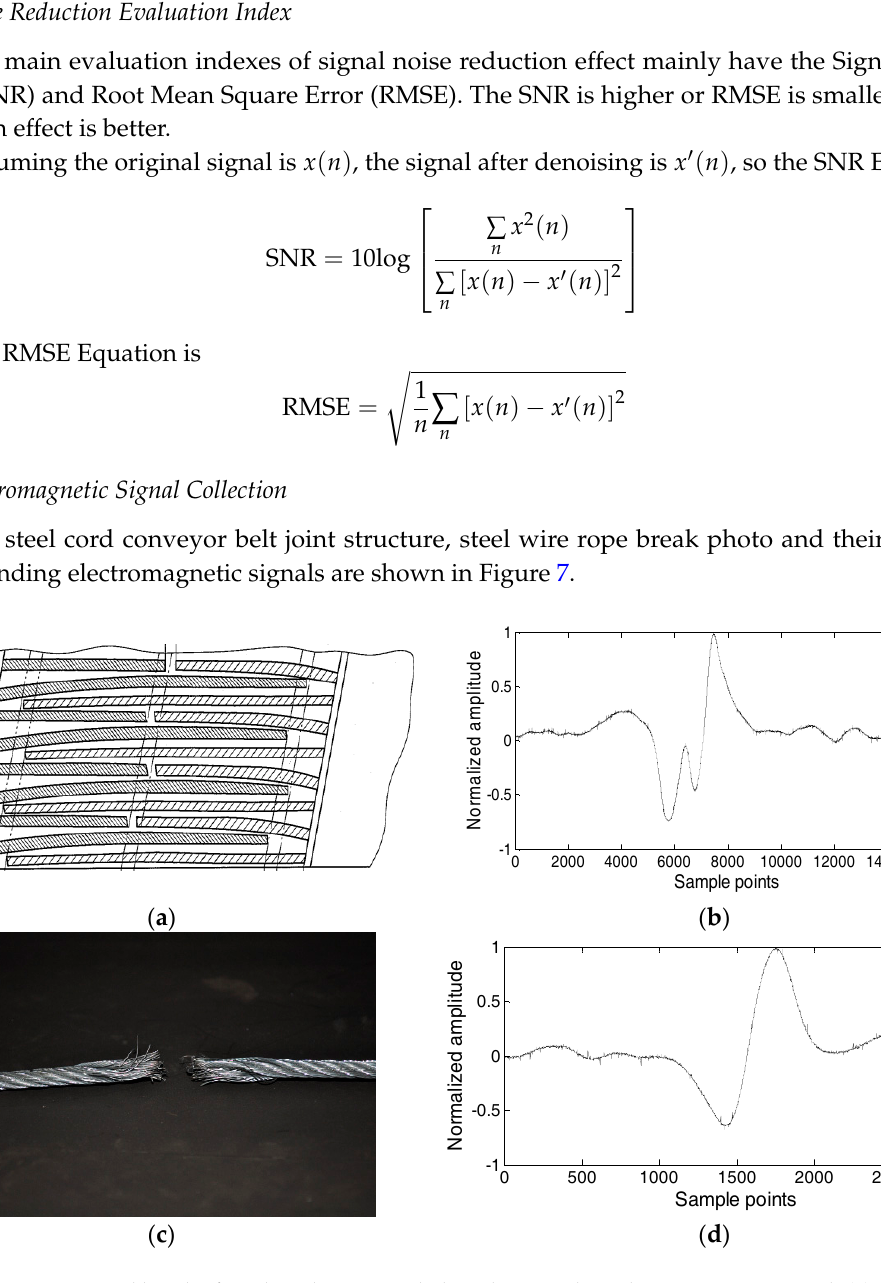
Figure 6. Electromagnetic testing rig of steel cord conveyor belt: ( a ) Tested belt conveyor prototype; ( b ) Installed electromagnetic testing device; ( c ) Electromagnetic testing system setup.